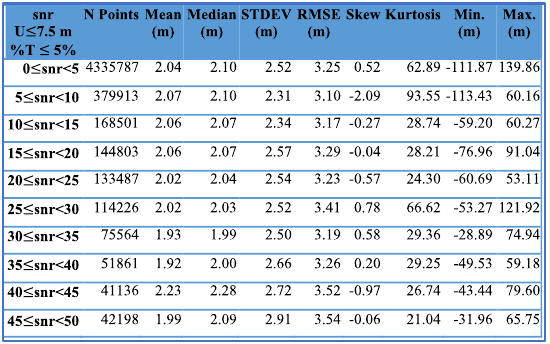
Table 4. Statistics for elevation differences SRTM90 –